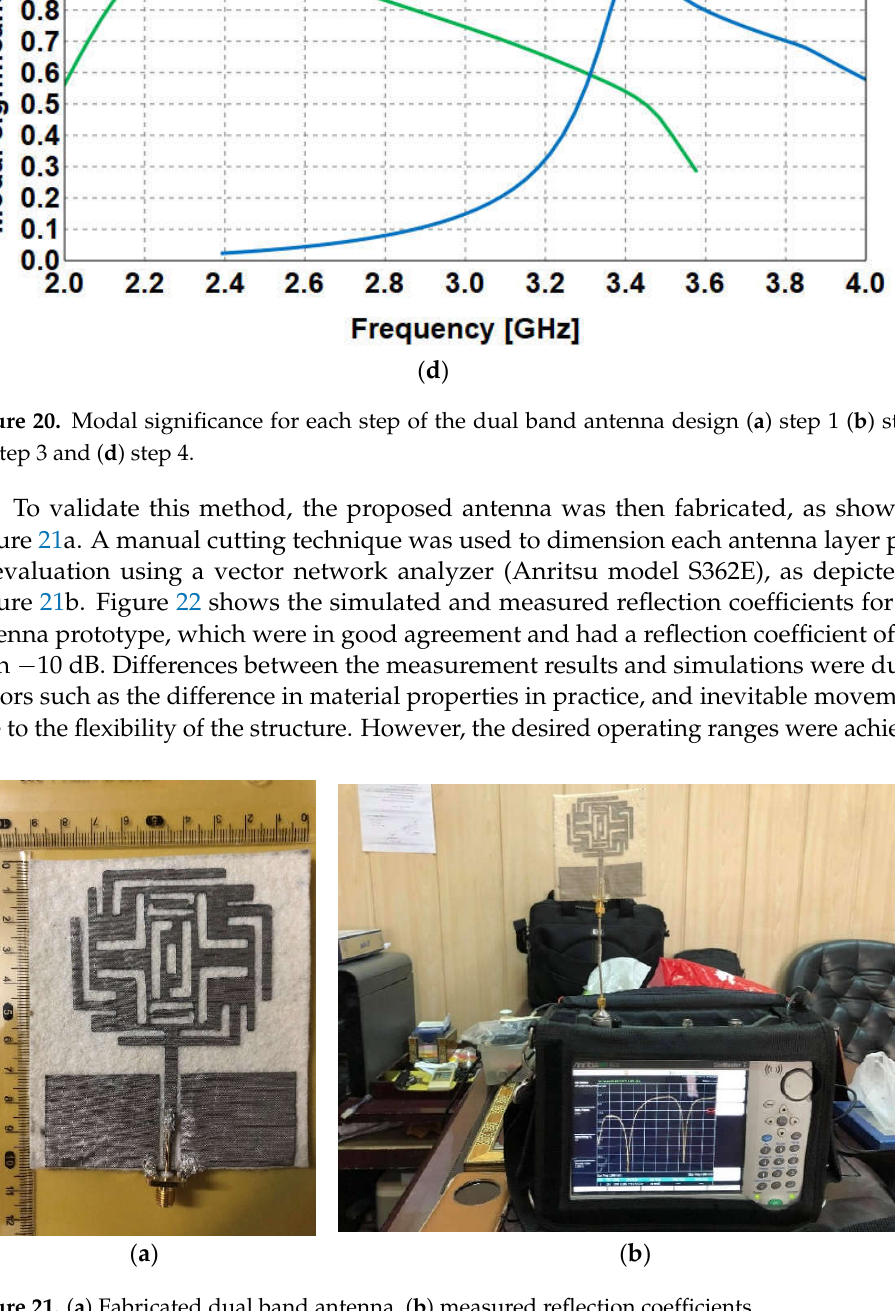
Figure 22. Simulated and measured reflection coefficients of the dual band textile antenna designed using this method. 4. Conclusions In this paper, a new procedure, based on the CMA technique, for quick estimation of patch antenna dimensions on different substrates was presented. For every antenna type, four steps were proposed to first introduce a curve-fitting formula to find the relationship between the variables obtained at different resonant frequencies. This then enables the quick estimation of the dimensions of the patch, using CMA, without including the substrate and excitation. Only four steps are needed to apply these formulae in estimating the dimensions of other more sophisticated designs. This supports the validity and simplicity of the formula presented in this study for electrically thin and thick MSAs, compared with other approaches in the literature. Furthermore, the proposed expression is suitable to design slotted antennas, with an average difference of 10%. As a final validation, a flexible CPW-fed antenna was designed based on this method. The dual- band antenna designed using this approach operated at 2.33 and 3.42 GHz with a minimum reflection coefficient of −35.1 and −19.2 dB, respectively. Its gains were improved by 6 and 3 dBi at 2.33 and 3.42 GHz, respectively, with simulations and measurement results showing satisfactory agreements.